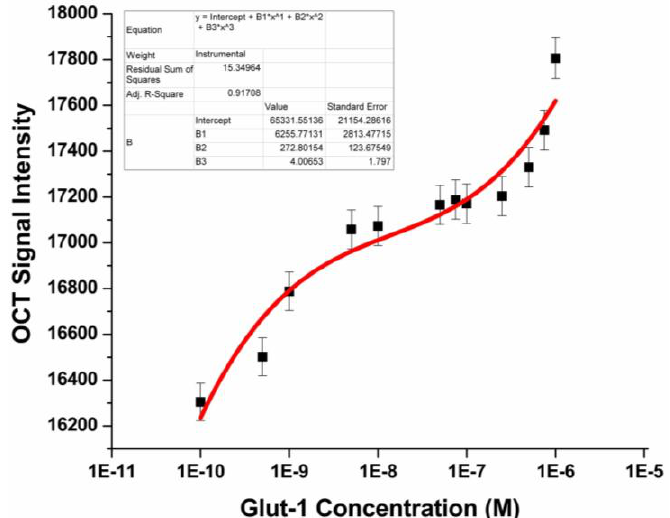
Figure 3. Calibration curve depicting averaged OCT signal intensity versus corresponding initial concentration of Glut-1